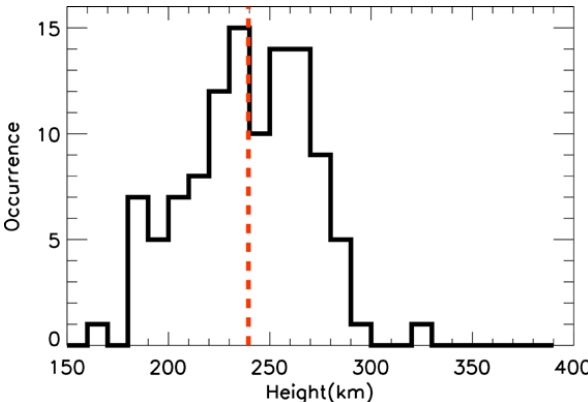
Fig. 5. Statistical histograms of average height for a total of 119 intervals in 2008. The red vertical dashed line illustrates 239km, which is the average height of the 119